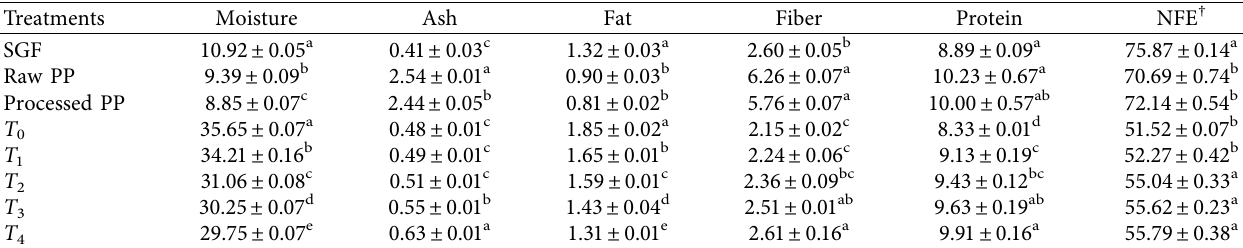
Values are means ± S.D. ( n � 2). Values having identical lettering in each column are nonsignificant at p > 0 . 05. T 0 � 100% straight-grade wheat powder chapatis (control),